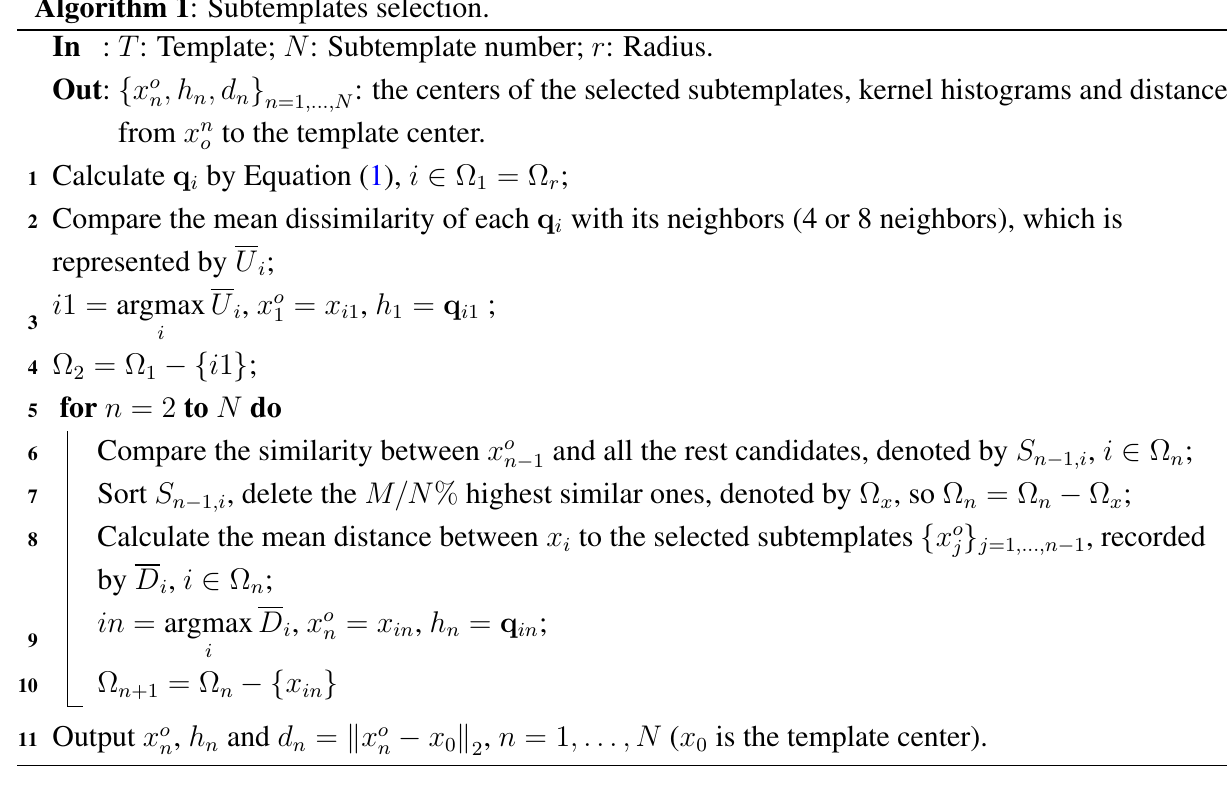
Algorithm 1 : Subtemplates selection.